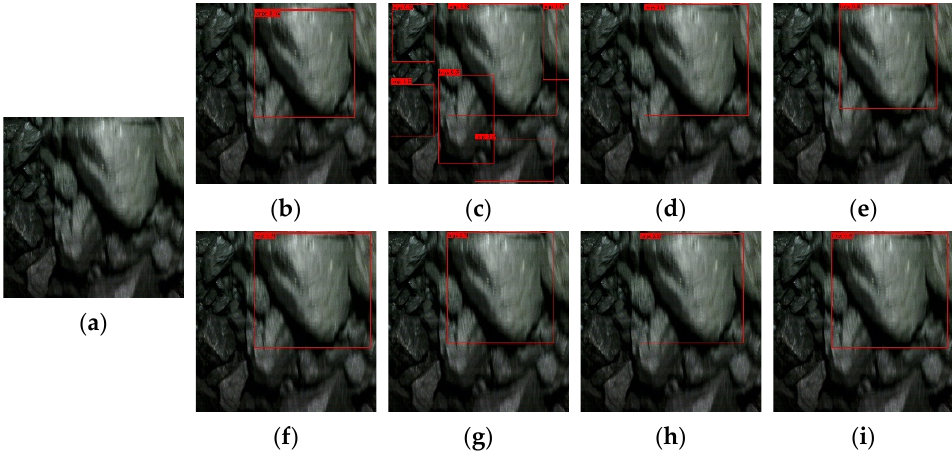
Figure 9. Results of big coal block detection via different networks—the first image. ( a ) origin; ( b ) SDD; ( c ) Faster ‐ RCNN; ( d ) RetinaNet; ( e ) YOLOv3; ( f ) YOLOv4; ( g ) YOLOv5 ‐ L; ( h ) YOLOX ‐ L; ( i ) YOLO ‐ BS.